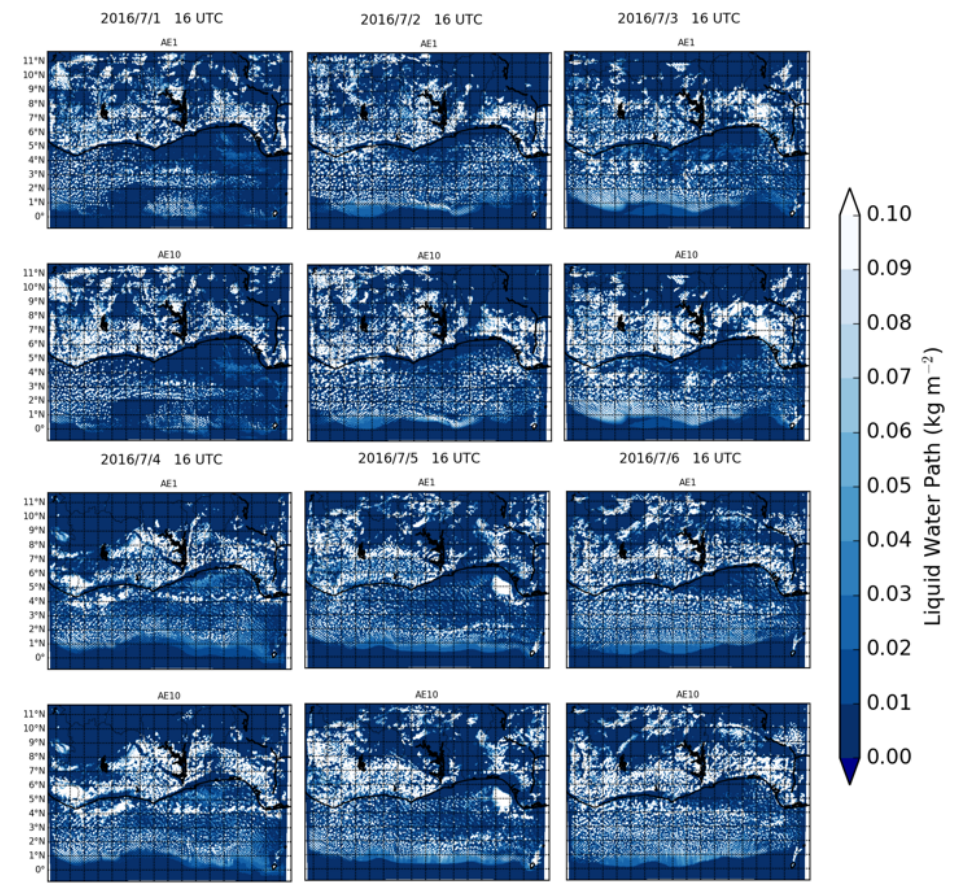
Figure A7. Modeled Liquid Water Path over the studied domain at 16:00UTC for the period 1–6 July 2016.